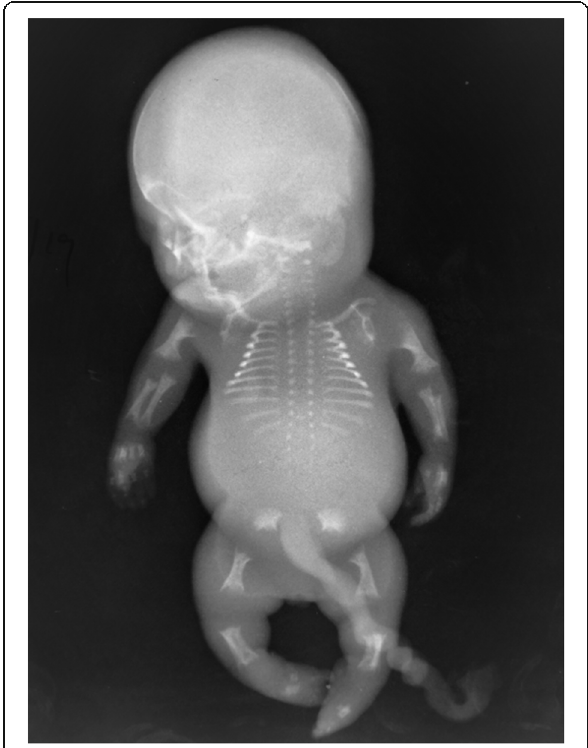
Fig. 5 Post-termination radiograph of abortus shows severely short fetal long bones, complete non-ossification of vertebral bodies (including sacrum), relative macrocrania, narrow thorax, shortening of the trunk, cupped appearance of ribs without any fractures and concavity of inferior and medial borders of the ilium. The metaphyses of long bones appeared flared with lateral spurs seen at proximal metaphyses of bilateral humeri and